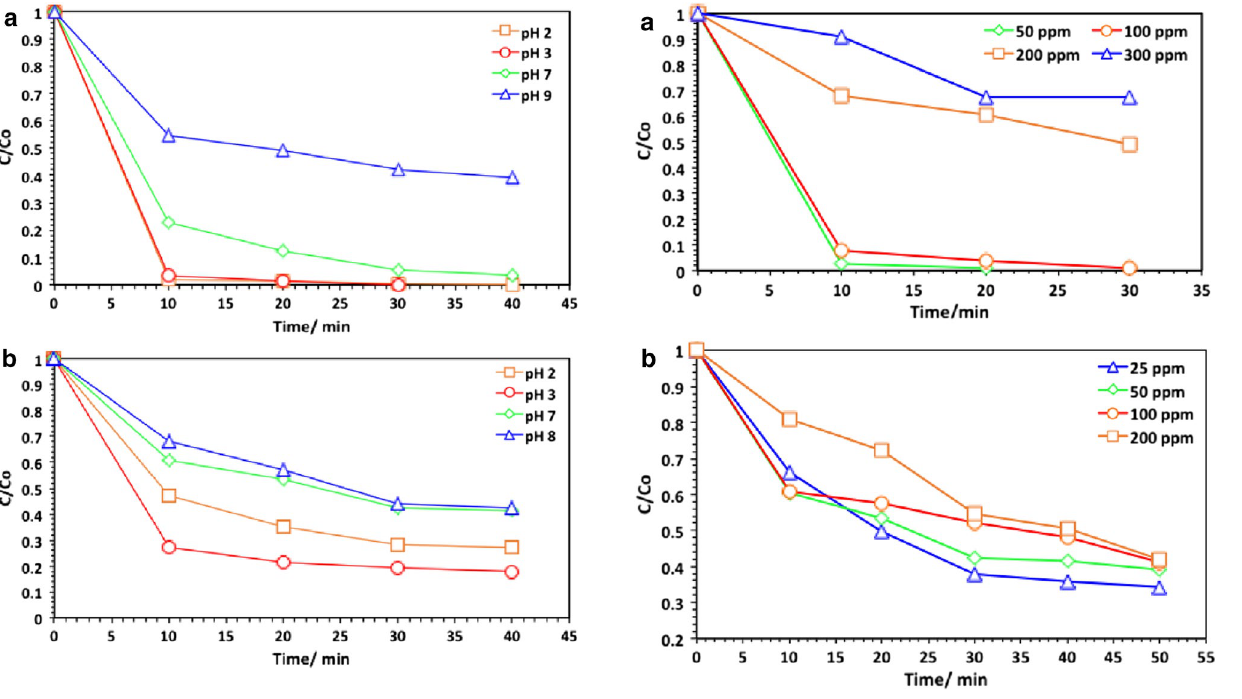
o 100 mg/L; Fig. 8 Effect of initial dye loadings on a LFR (H2O2 800 mg/L; AS400 1 g/L; pH 3.0) and b LA (H 2 O 2 200 mg/L; AS400 1 g/L; pH 3.0) azo-dyes removal during oxidation for different time ( t